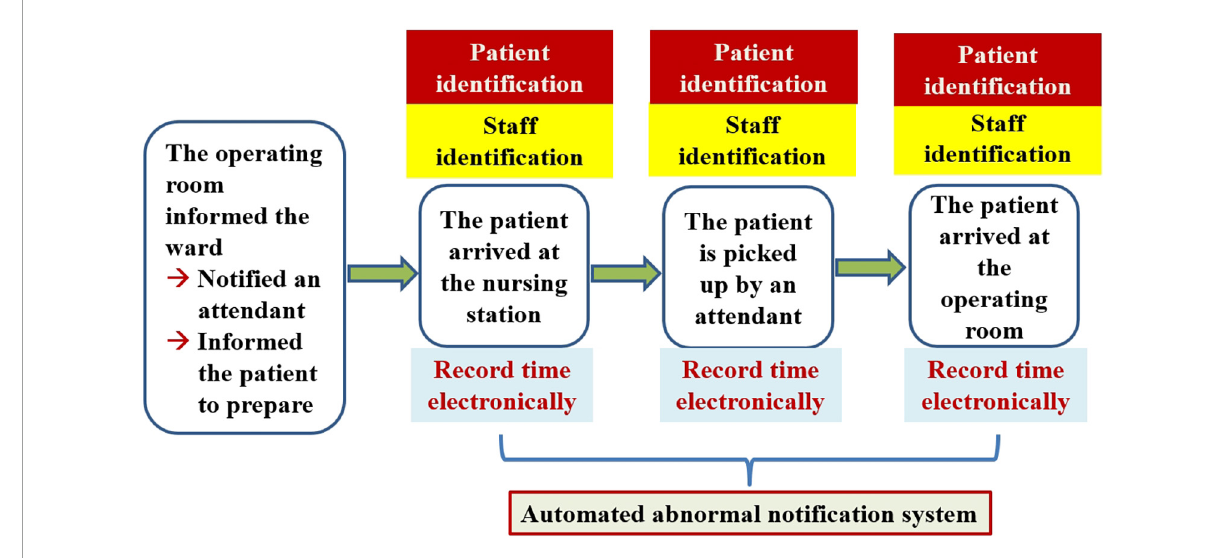
FIGURE11 Final future